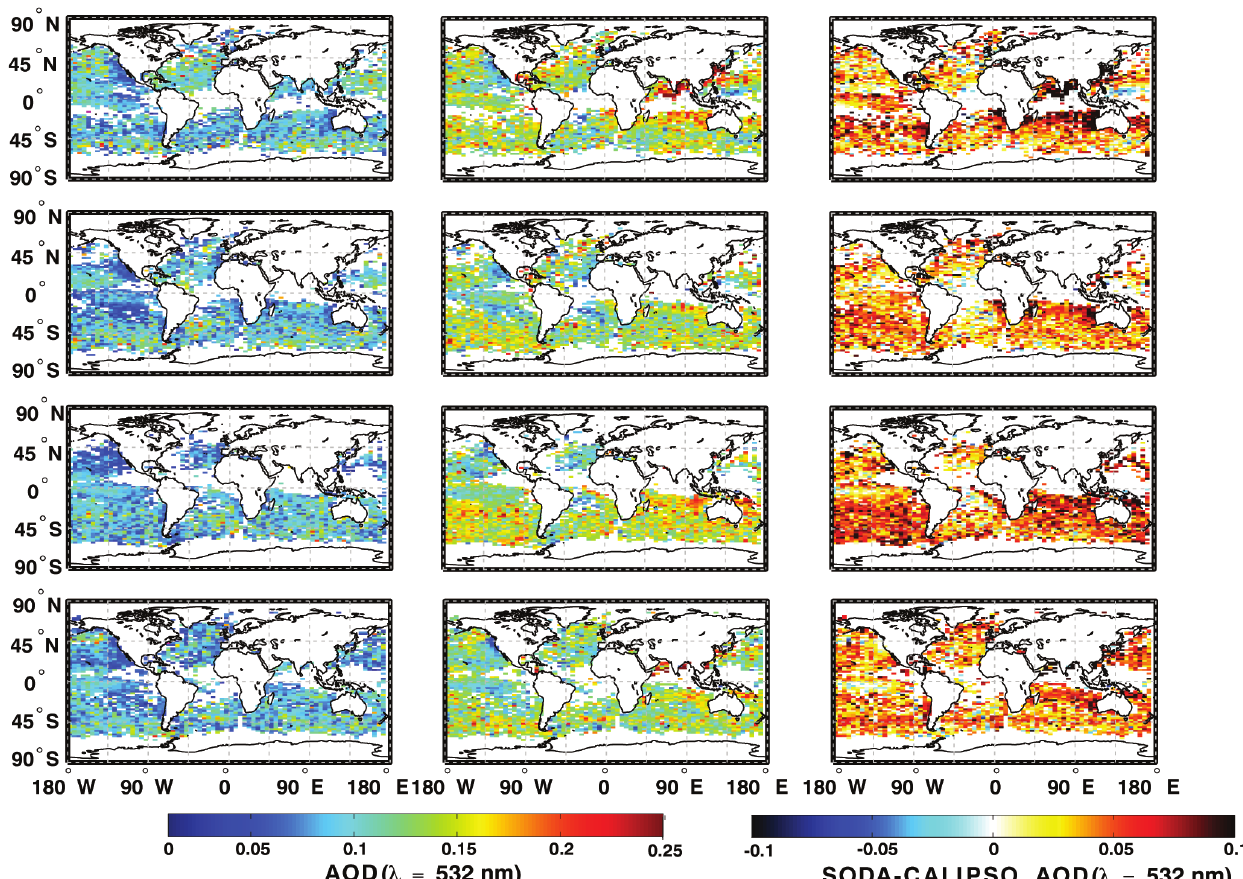
Figure 1. Seasonal median AOD values from CALIOP and SODA (columns 1 and 2) and the difference (SODA − CALIOP) plot (column 3) for December–February (row 1), March–May (row 2), June–August (row 3), and September–November (row 4) plotted on a 2 ◦ × 5 ◦ latitude longitude grid. “No data” areas are shaded white and defined as grid cells failing the quality-control algorithm (see text for